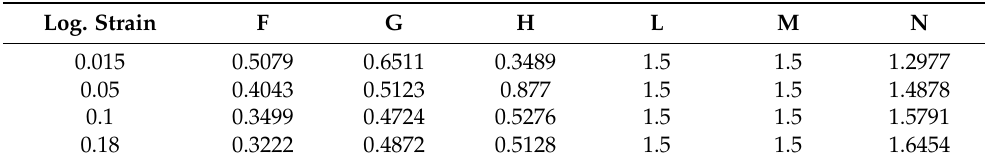
Table 2. Anisotropic parameters in the Hill’48 yield function for rolled ZAX210 alloys at room tem-